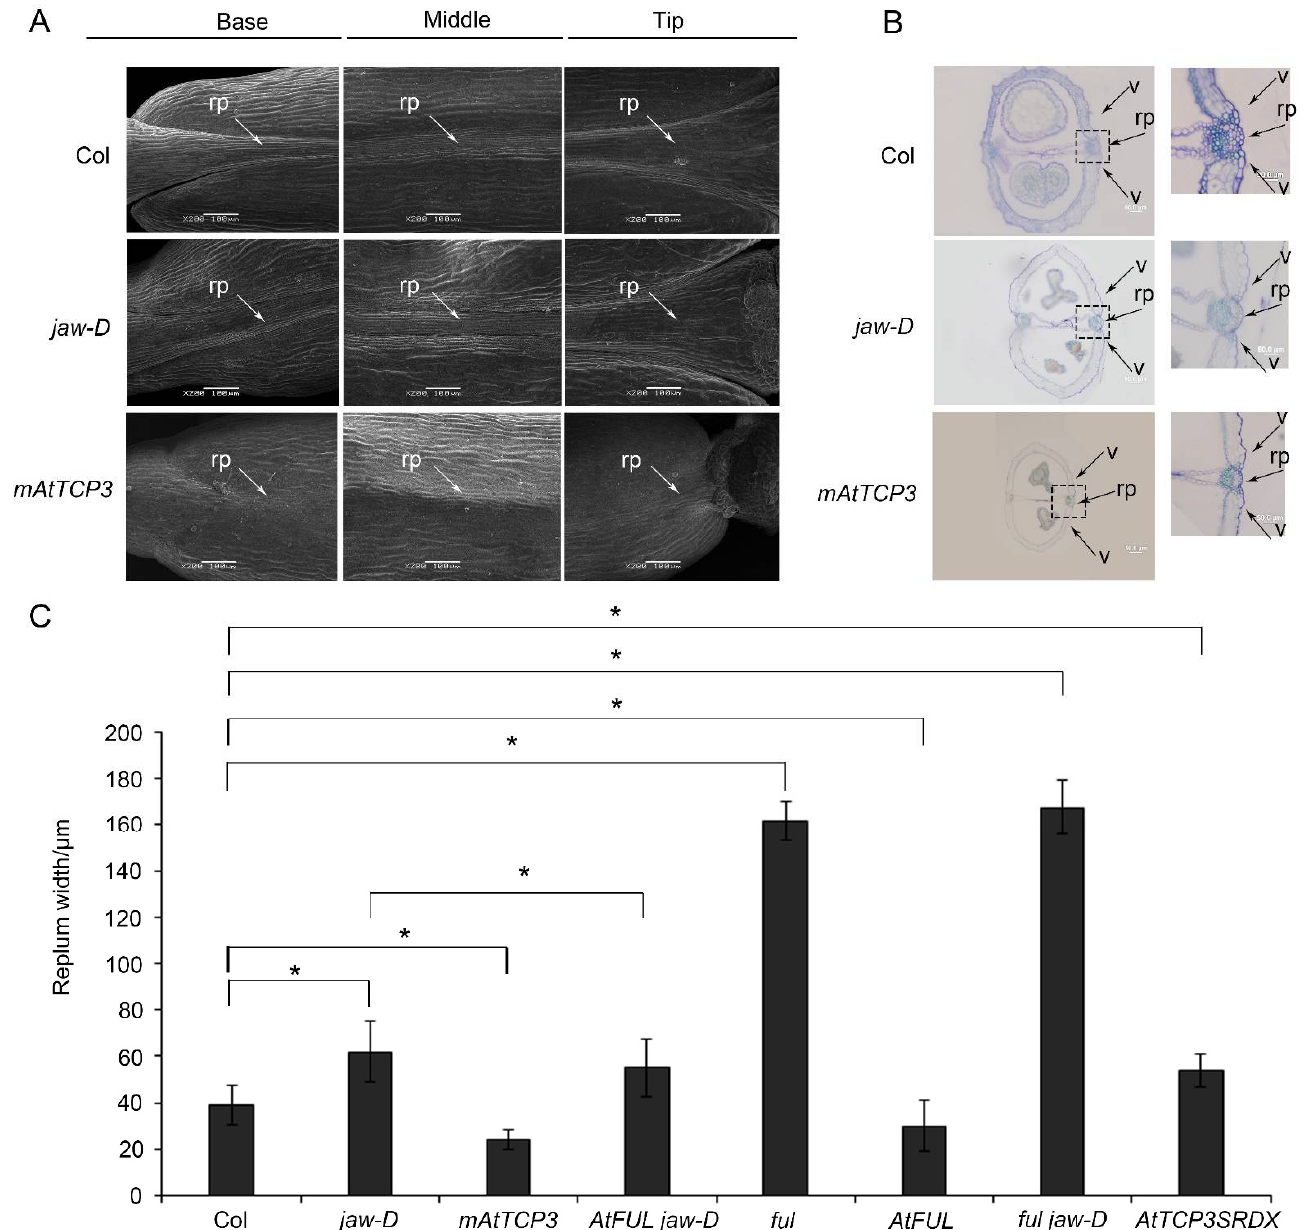
Figure 1. The phenotypes of the repla and dehiscence zones in Col (wild-type), jaw-D mutant and p35S::mAtTCP3 plants. ( A ) Images of scanning electron microscope (SEM) showing the repla of the wild-type, jaw-D , and mAtTCP3 siliques. ( B ) Cross-sections of siliques (stage 17) showing repla and valve margins of the wild-type, jaw-D , and mAtTCP3 siliques in Arabidopsis . The repla and valve margins in boxes were magnified in right. ( C ) Bar graph showing replum width of the wild-type (Col), jaw-D , mAtTCP3 , FUL jaw-D , ful , AtFUL , ful jaw-D , and AtTCP3SRDX siliques. mAtTCP3 , p35S::mAtTCP3 lines. AtFUL , p35S::AtFUL lines. FUL jaw-D , p35S::AtFUL in jaw-D mutant. ful jaw-D , double mutants. AtTCP3SRDX , pAtTCP3:: AtTCP3SRDX . rp, replum. v, valve. * indicates p < 0.05.